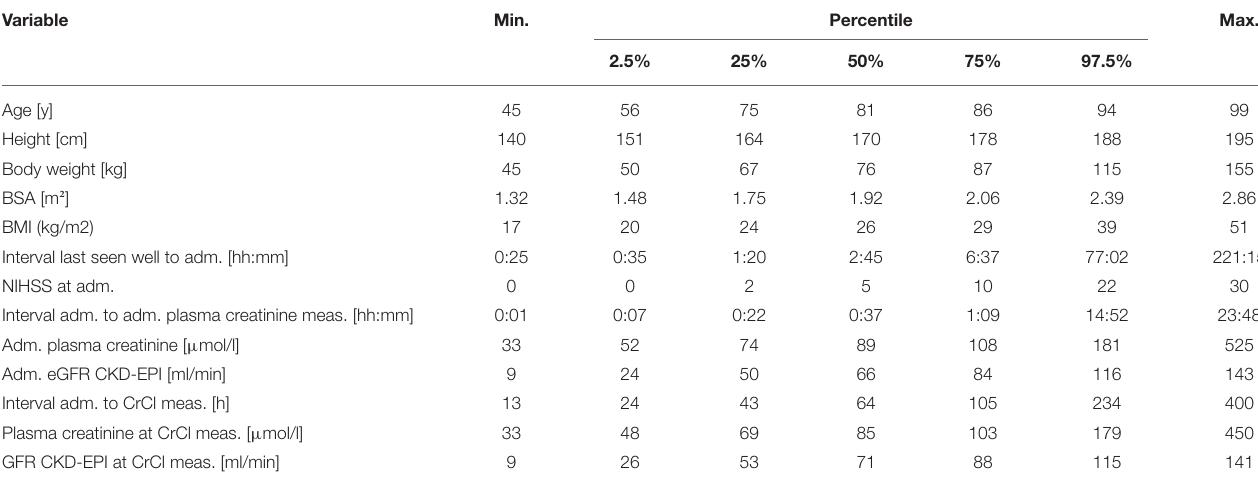
TABLE 2 | Variables of the 481 study patients and their distributions. Variable Min.